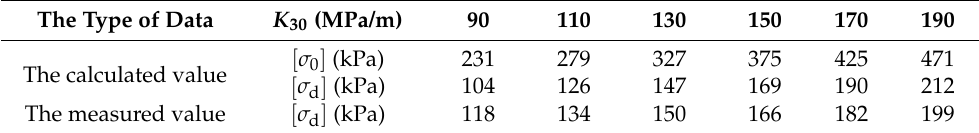
Table 8. K 30 and the critical dynamic strength of the corresponding subgrade